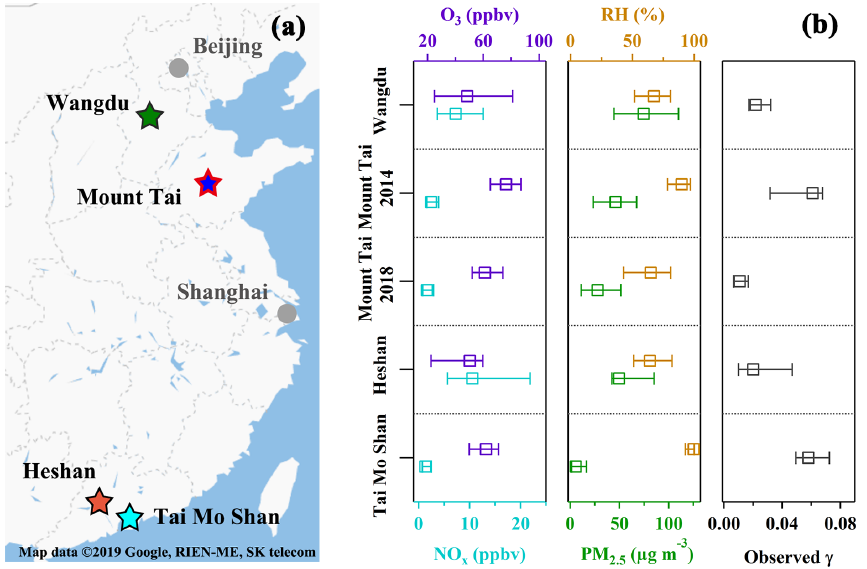
Figure 1. (a) The locations of the four field measurement sites (star markers) in China. (b) Comparisons of the concentrations of O 3 , NO x , PM 2 . 5 , and observed RH and γ N during the five campaigns in China. Squares represent the median values and bars represent the 2 O 5 interquartile ranges of the values in the five measurements. It should be noted that the high RH in Mt. Tai in 2014 and Tai Mo Shan campaigns were caused by frequent cloud or fog events, and the γ N was determined only during noncloudy periods in these two 2 O 5